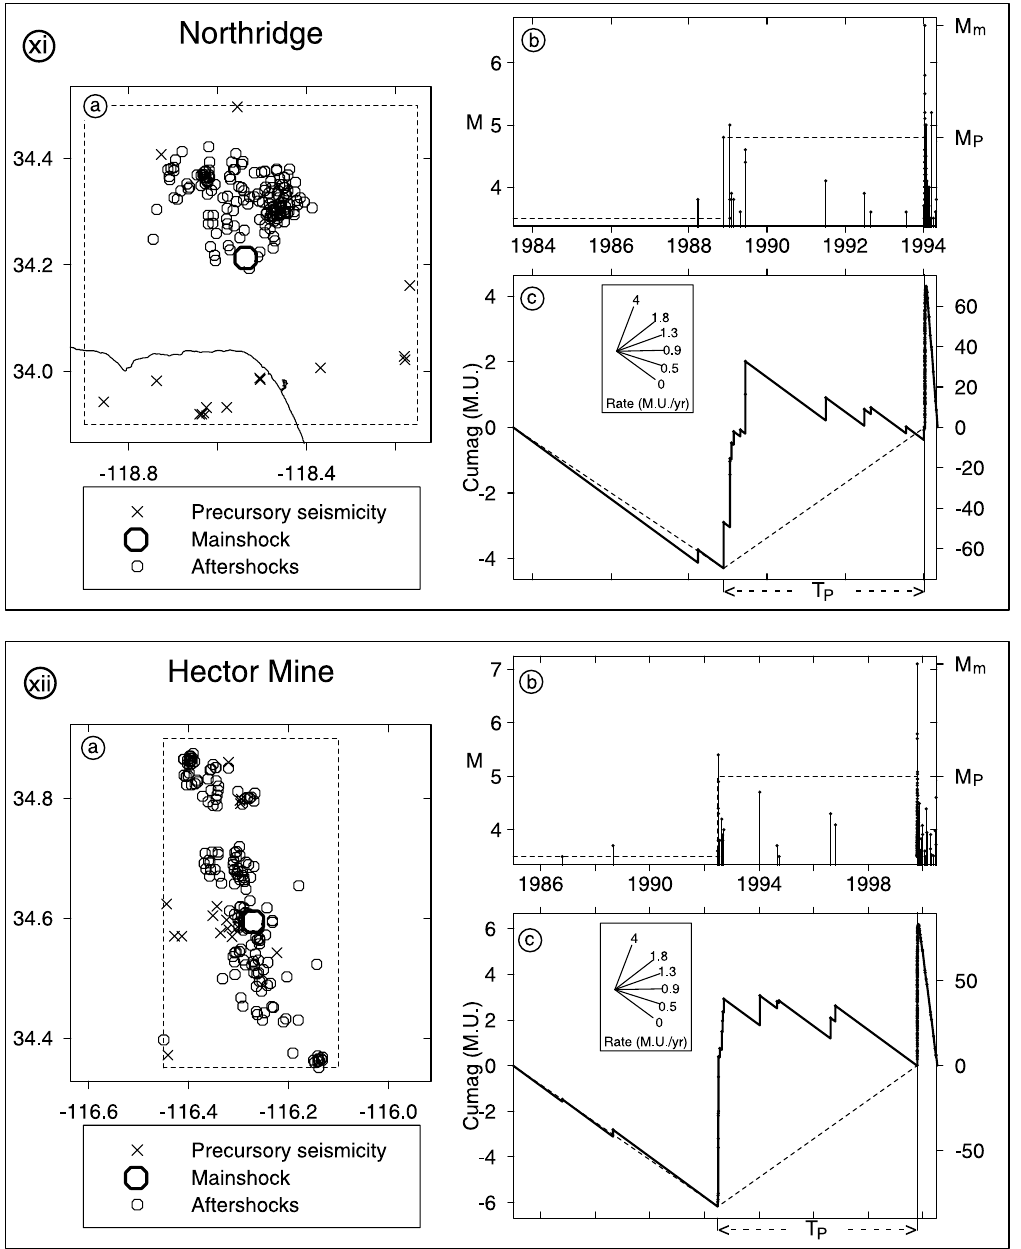
Fig. 3xi,xii. (cid:115) -phenomenon: data and interpretation for major earthquakes at (xi) Northridge and (xii) Hector Mine. For explanation see caption fig.